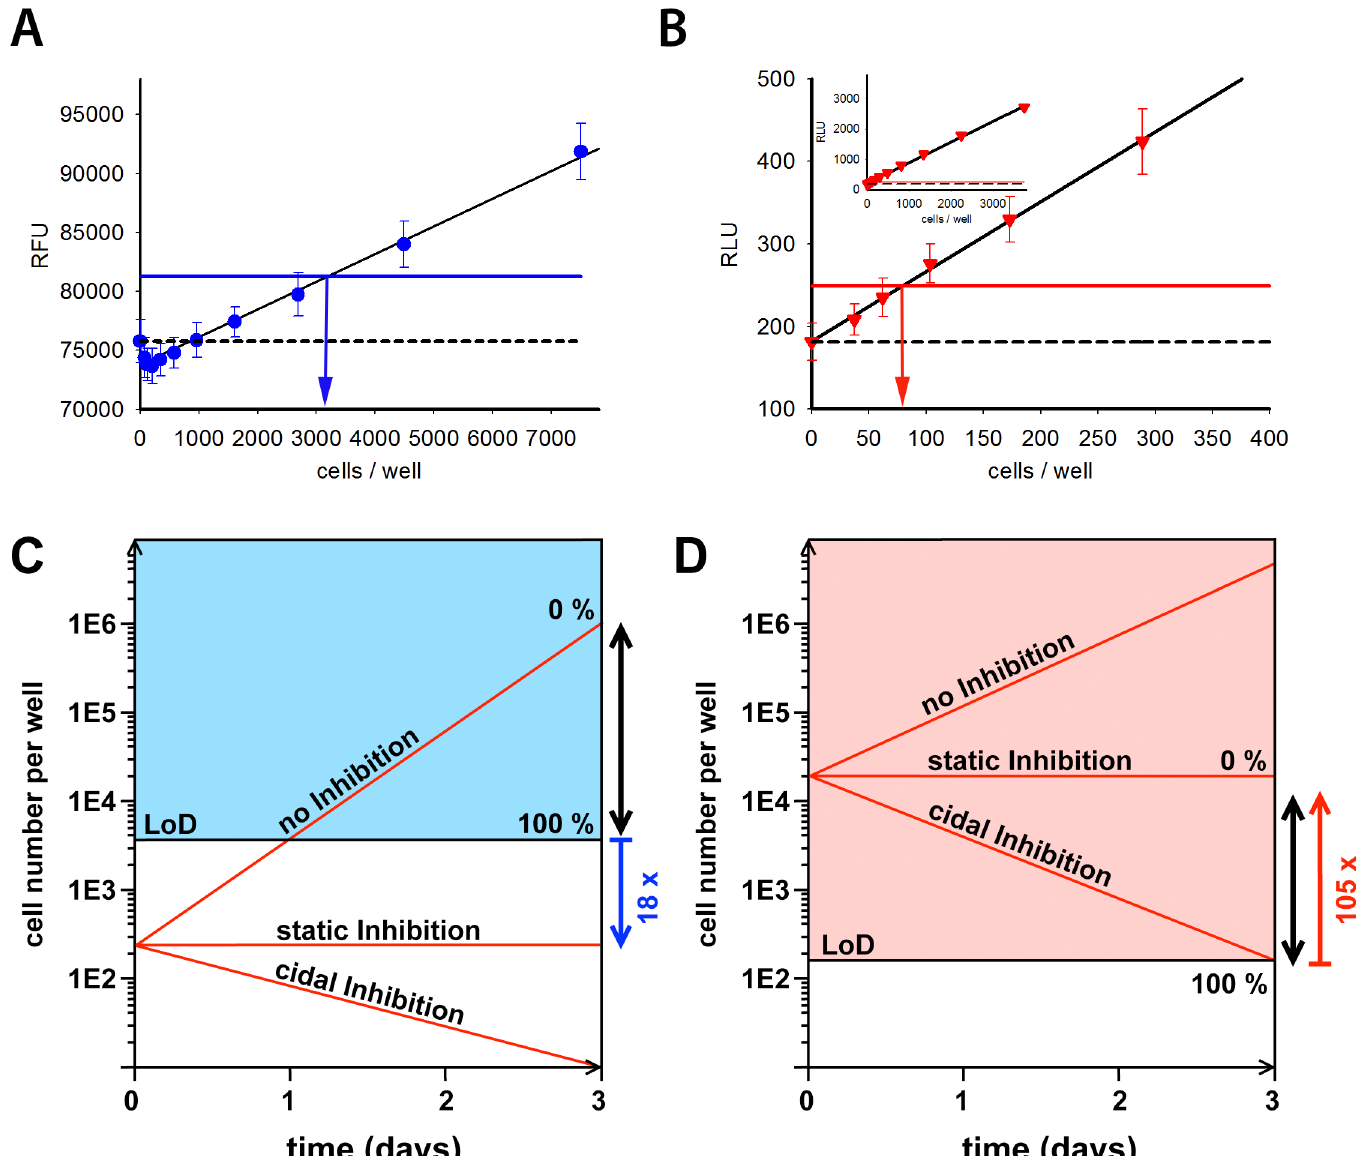
Fig 1. Limit-of-detection of historic and novel axenic assay and assay models. A: Detection limit of the historic axenic assay. Black line shows the linear regression (R 2 = 0.983, p < 0.0001). Dashed line shows average value of blanks. Blue line shows detection limit (3x standard deviation above the blanks value) for this assay. Vertical blue arrow indicates the number of cells at the limit of detection in this single experiment. Data is from a representative experiment of 4 with a minimum of 24 technical replicates. B: Detection limit of the novel axenic assay. Black line shows the linear regression (R 2 = 0.998, p < 0.0001). Dashed line shows average value of blanks. Red line shows detection limit for this assay (3x standard deviation above the blanks value). Red vertical arrow indicates the number of cells at the limit of detection in this single experiment. Data is from a representative experiment of 4 with a minimum of 24 technical replicates. Inset shows data from a similar range of cell densities as used in 1A. C and D: The coloured areas represent cell densities that can be detected with the respective assay formats (C: historic axenic assay, D: novel axenic assay). Red lines represent different cell-growth inhibition scenarios during the course of this assay: compounds that do not inhibit cell growth (marked “ no Inhibition ” ), compounds that arrest cell growth, without killing cells (marked “ static Inhibition ” ), and compounds that kill cells (marked with “ cidal Inhibition ” ). The black double arrows represent the analysis window. Blue (historic assay) and red (novel assay) arrows show the fold difference between the starting density and detection limit. stock used or cell passage number used (Fig A-C in S1 Text). Two independent replicates of a set of 35 compounds in potency mode demonstrated very good reproducibility (R 2 = 0.95, Fig